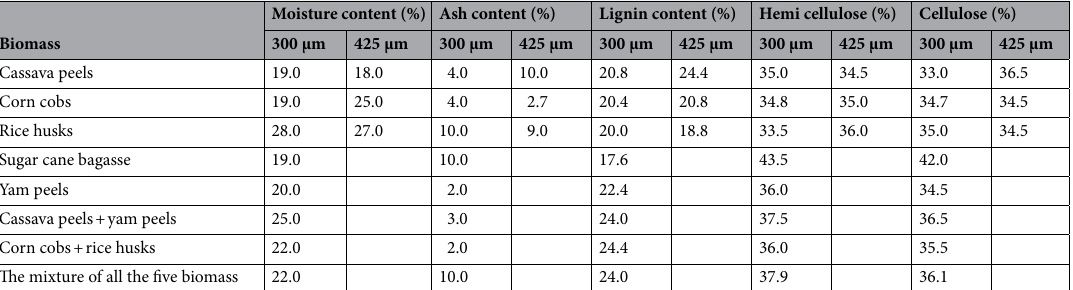
Table 2. Proximate analysis result for hydrothermal and acid-based pretreated samples.